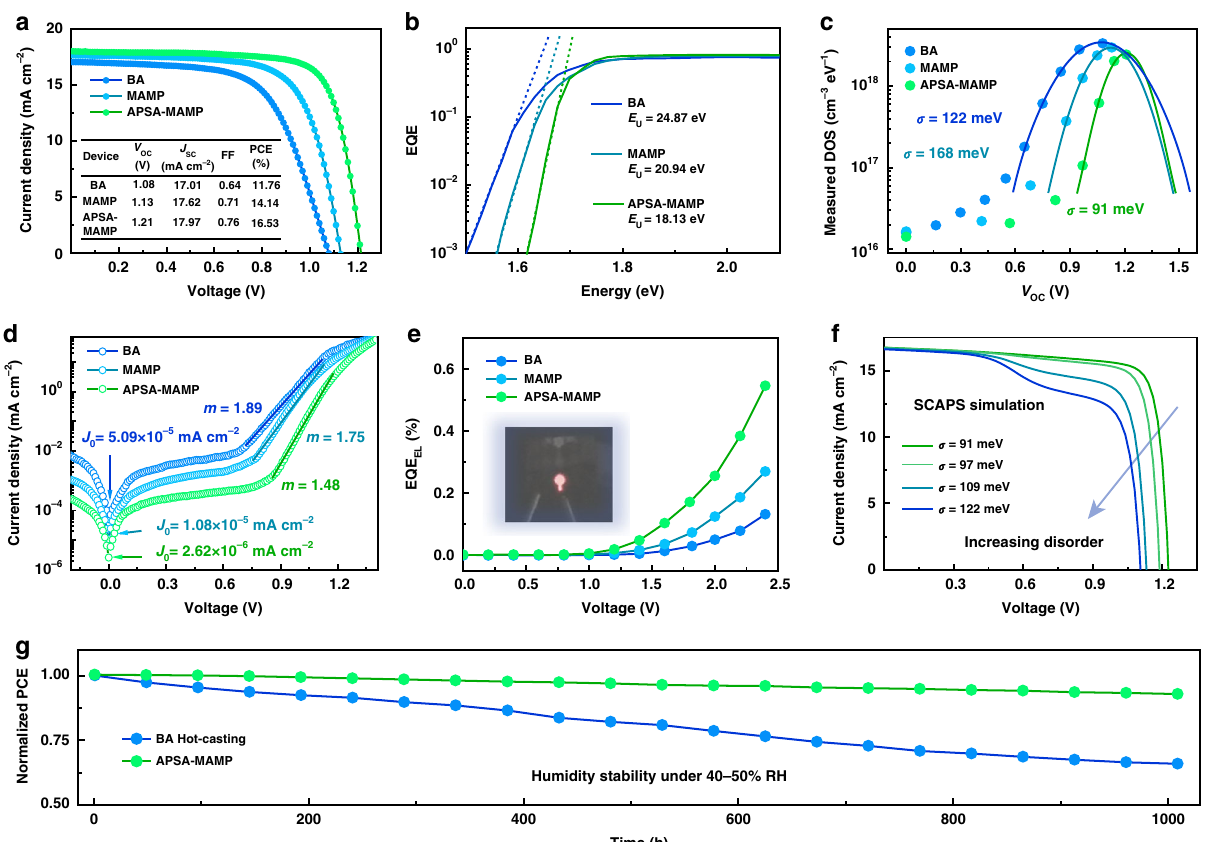
Fig. 5 Photovoltaic performance and V oc loss mechanism investigation. a J – V curves of (BA) 2 (MA) 3 Pb 4 I 13 , pristine, and APSA-treated (MAMP) MA 3 Pb 4 I 13 devices. b E U extracted by band edge fi tting of the exponentially plotted EQE spectra. c DOS for different perovskites extracted from the impedance spectra. d Dark J – V curves for different perovskite devices. e EQE EL spectra for three different perovskite devices. f SCAPS simulation of (MAMP)MA 3 Pb 4 I 13 photovoltaics with experimental parameters extracted from different degrees of disorder fi lms. g PCE evolution curves for unencapsulated APSA-treated (MAMP)MA 3 Pb 4 I 13 devices, and the (BA) 2 MA 3 Pb 4 I 13 devices fabricated by traditional hot-casting method, under humidity of 40 – 50% RH (relative